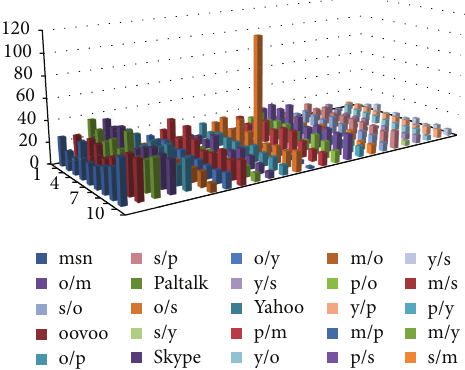
Figure 16: Experimental results of AC method.